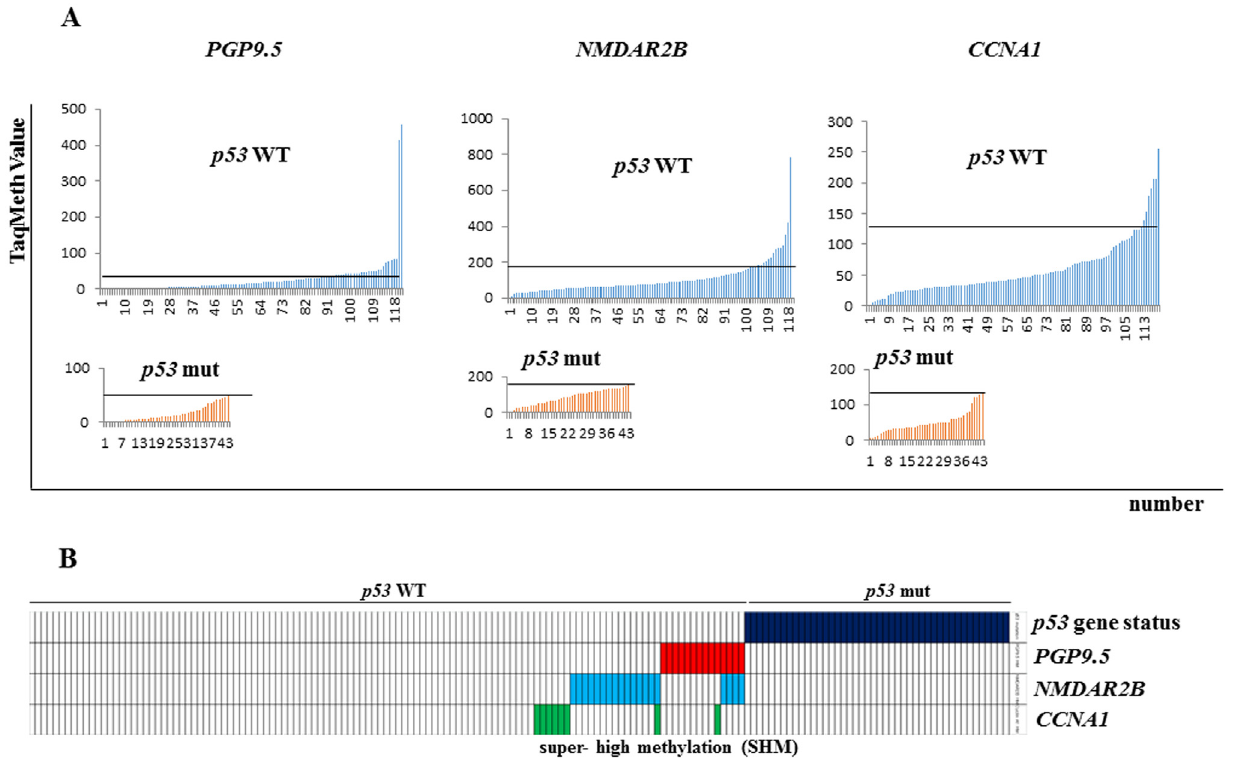
Fig 3. TaqMeth value of PGP9 . 5 , NMDAR2B , and CCNA1 in pStage II/III gastric cancer. (A) Methylation of the indicated genes was analyzed using Q-MSP and TAqMeth values in tumors with p53 wild type were compared with those with p53 mutation. The threshold value for determination that a gene was methylated was determined as the maximum TaqMeth value of p53 wild type. (B) Tumors with p53 wild type or p53 mutation were compared in terms of the presence of super-high methylation of the indicated genes. Super-high methylation was defined that at least one gene showed higher TaqMeth value than each threshold values among three